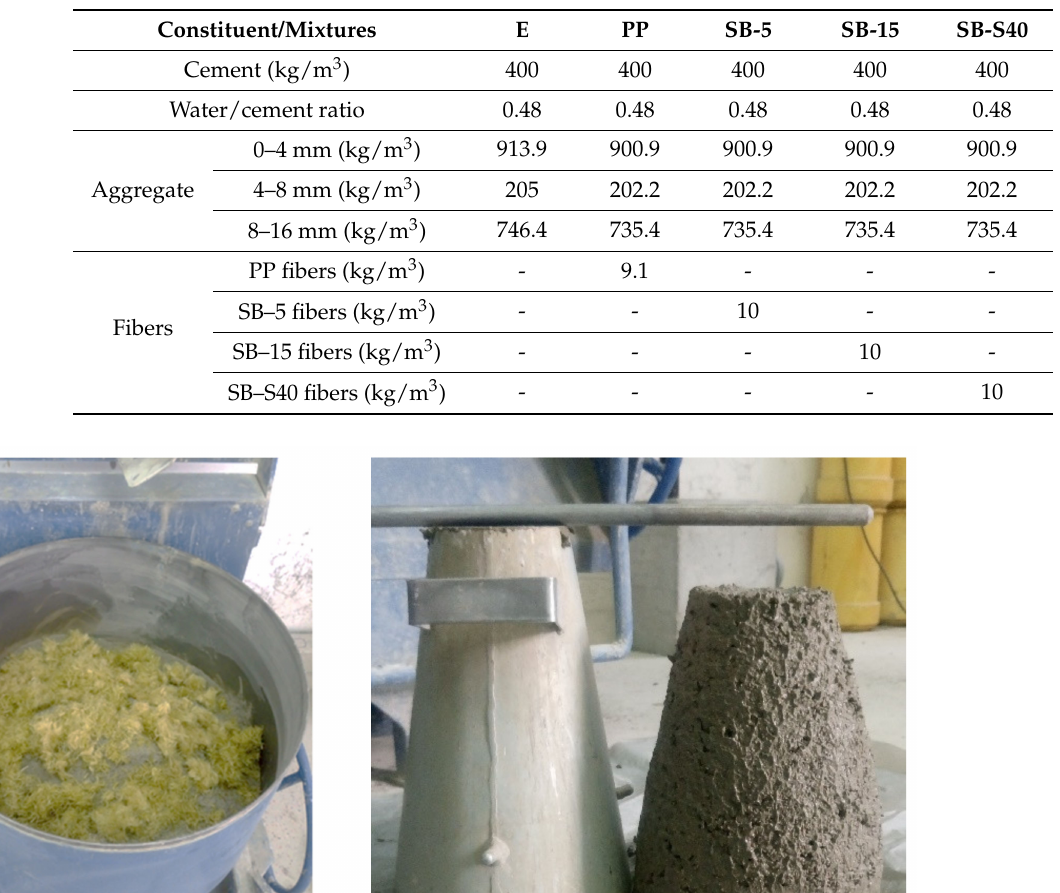
Table 2. Concrete mixtures.